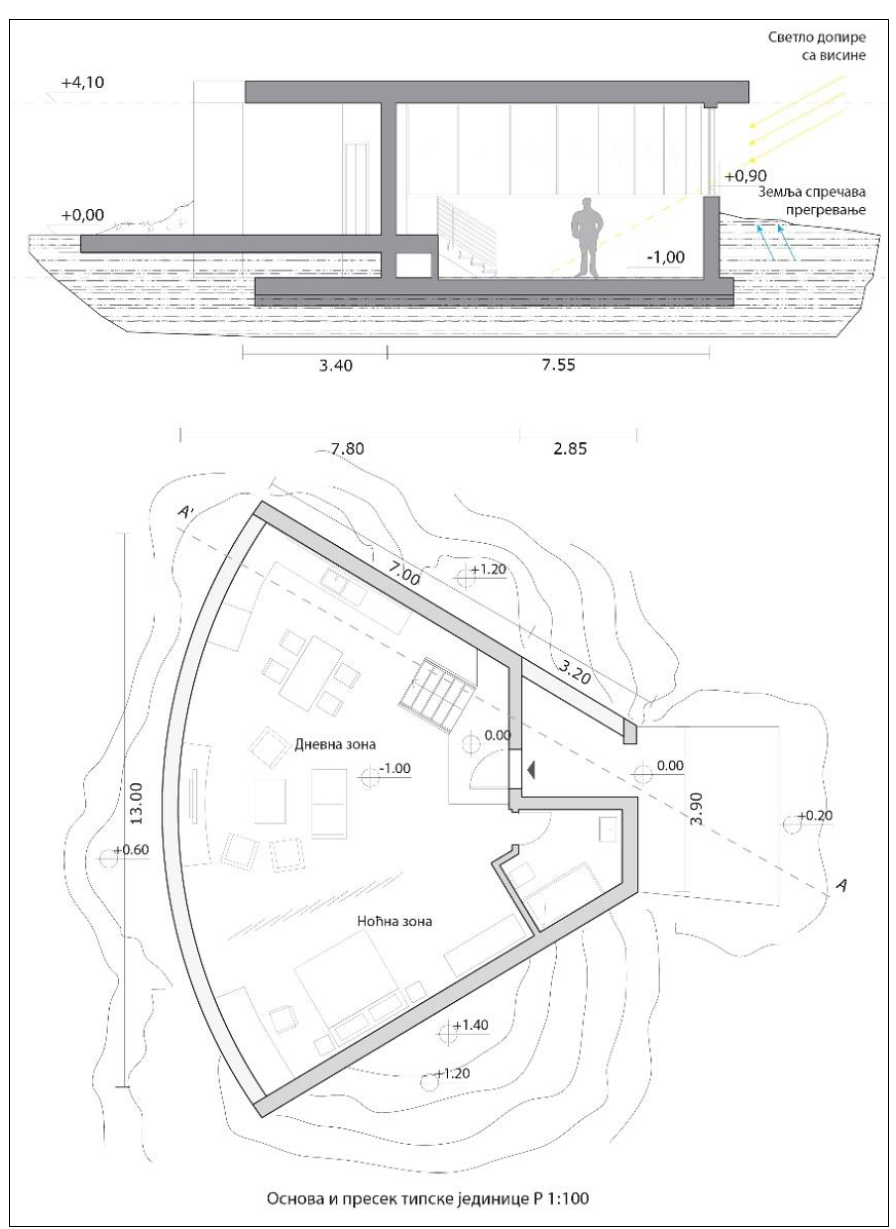
Figure 35. Basis and cross-section of a typical residential unit. Lepenski Vir, Serbia (2019) by ArhiArhi (Predrag, Vladimir and Grigor